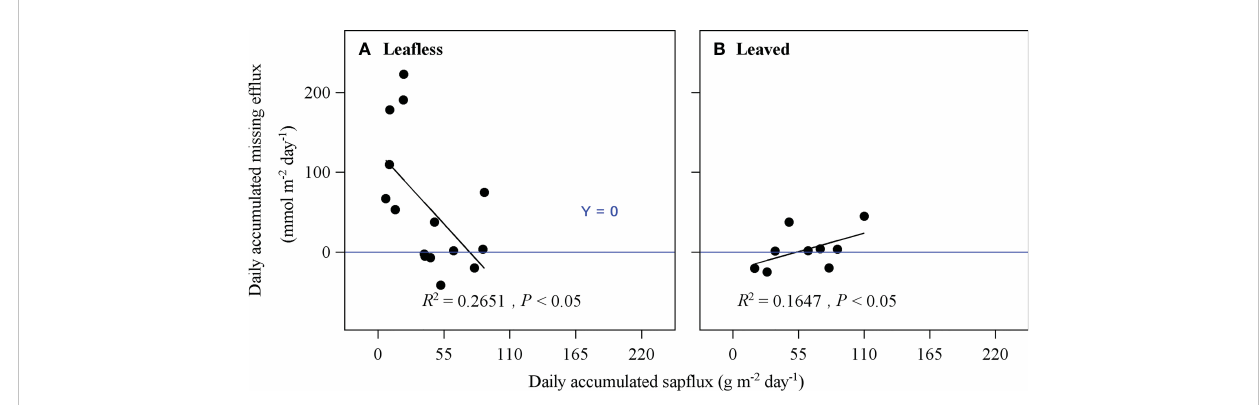
FIGURE 9 Relationships of daily accumulated sap fl ux and daily accumulated missing ef fl ux of the light-proof chamber (i.e., exclude culm photosynthesis) in lea fl ess (A) and leaved (B) stages. Note that missing ef fl ux is the difference between the theoretical culm respiration and the surface-released CO 2 ef fl